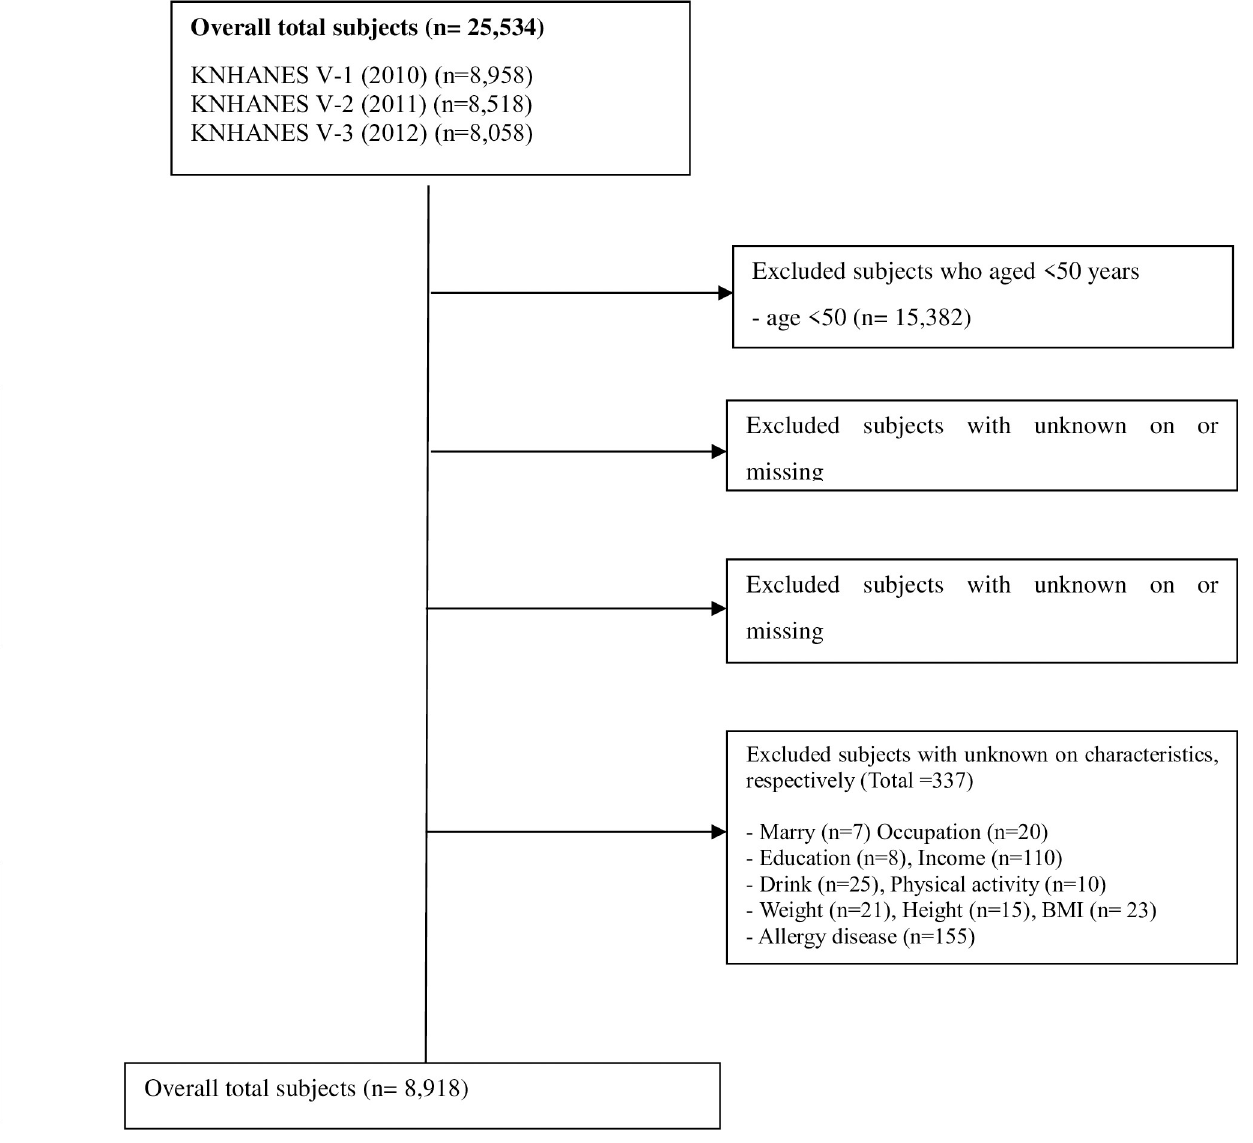
Fig 1. Subjects’ flow